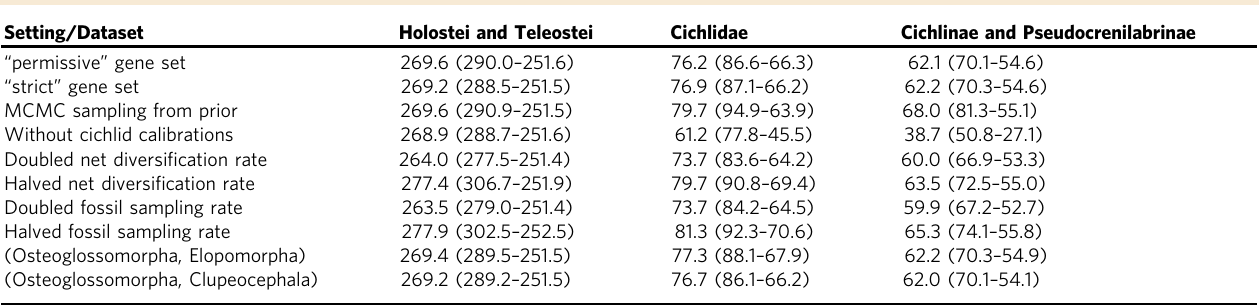
estimates obtained with the “ permissive ” gene set correspond to those shown in Fig.